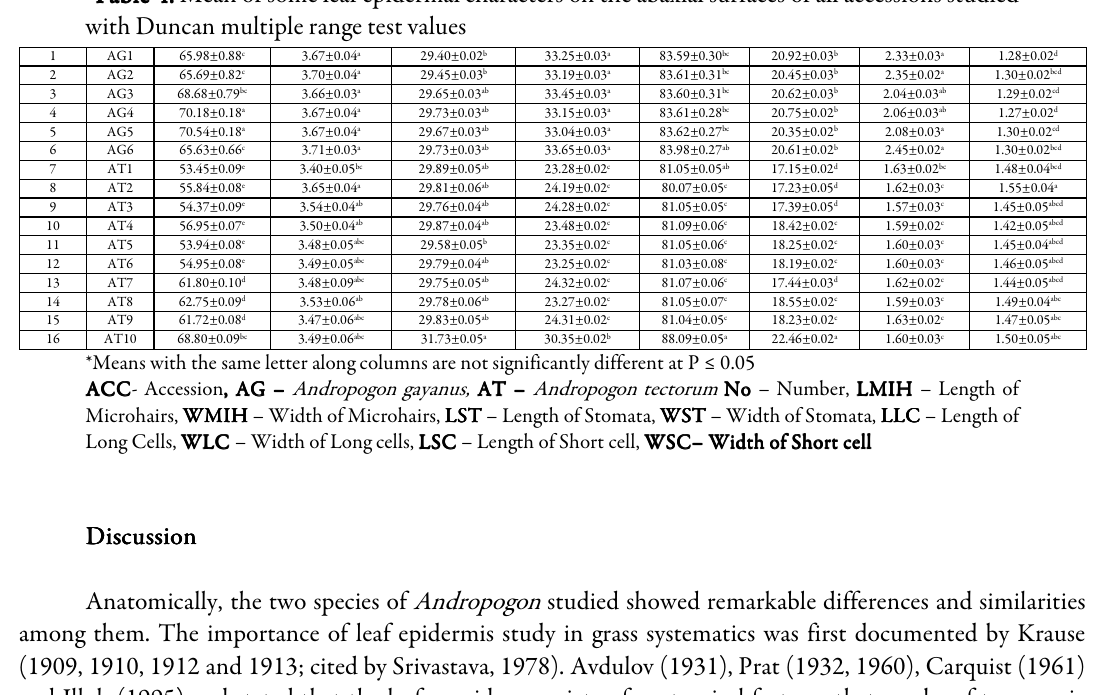
Table 4. Mean of some leaf epidermal characters on the abaxial surfaces of all accessions studied with Duncan multiple range test values